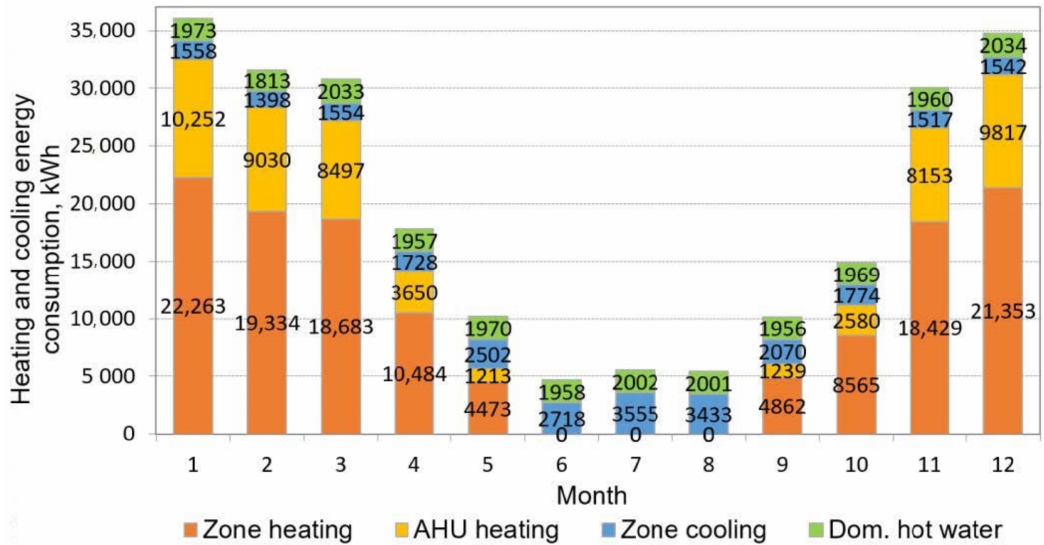
Figure 8. Monthly heating and cooling energy consumption in the CEEE’s